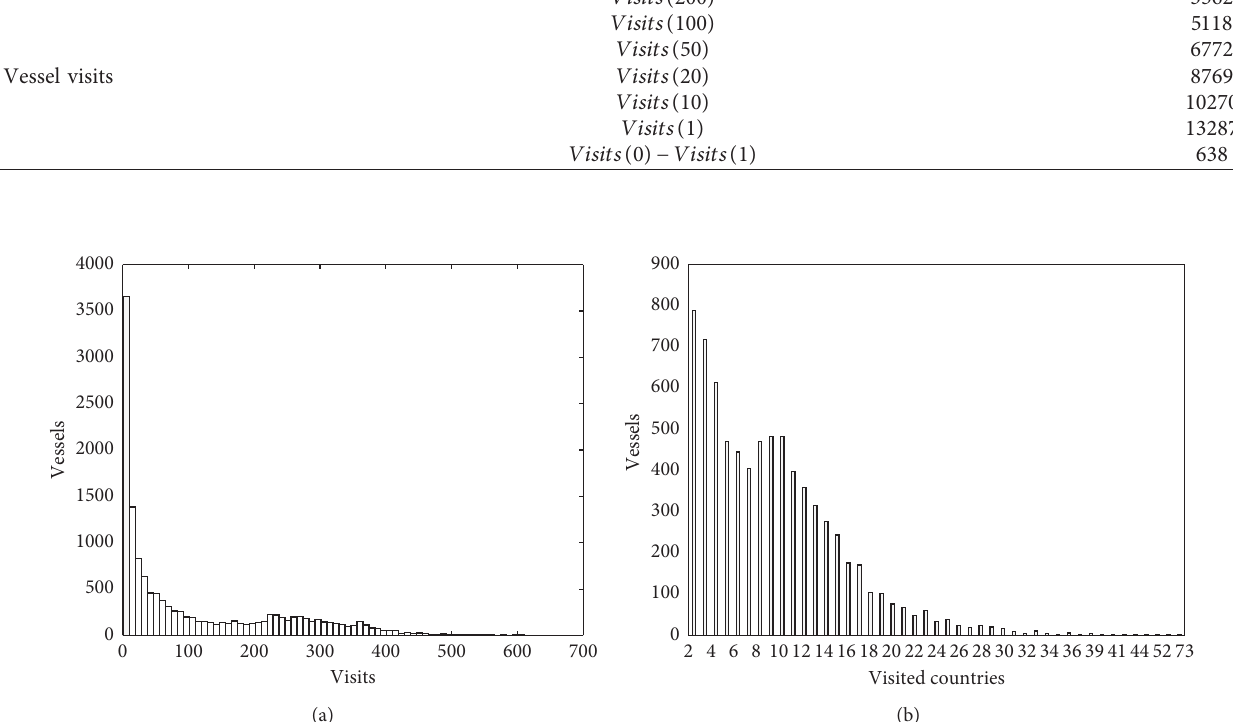
Figure 2: Vessel visiting times and countries. (a) Visits ( i ) − Visits ( i + 1 ) . (b) Countries ( v ) .